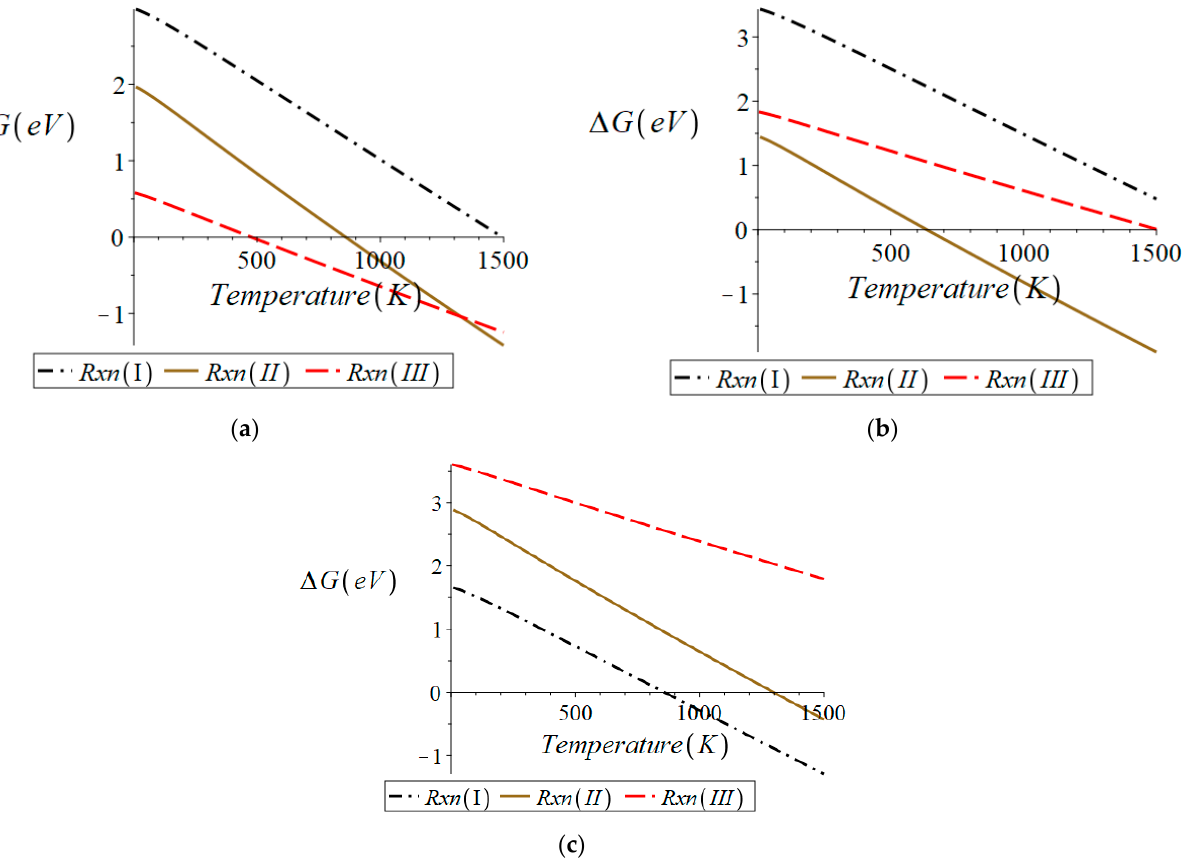
Figure 4. Surface of cubic BCF1585 for ( a ) surface with no oxygen defects, ( b ) surface with 1 oxygen vacancy, ( c ) surface with 2 oxygen vacancies. Plots were generated in Maple TM .